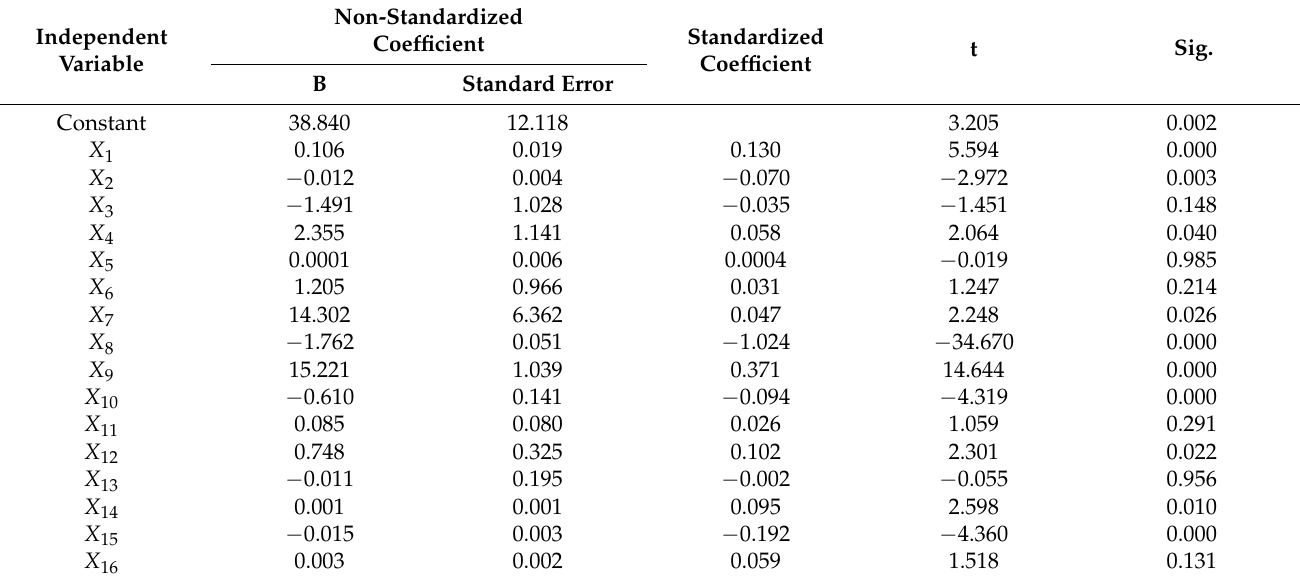
Table 4. Model coefficient.